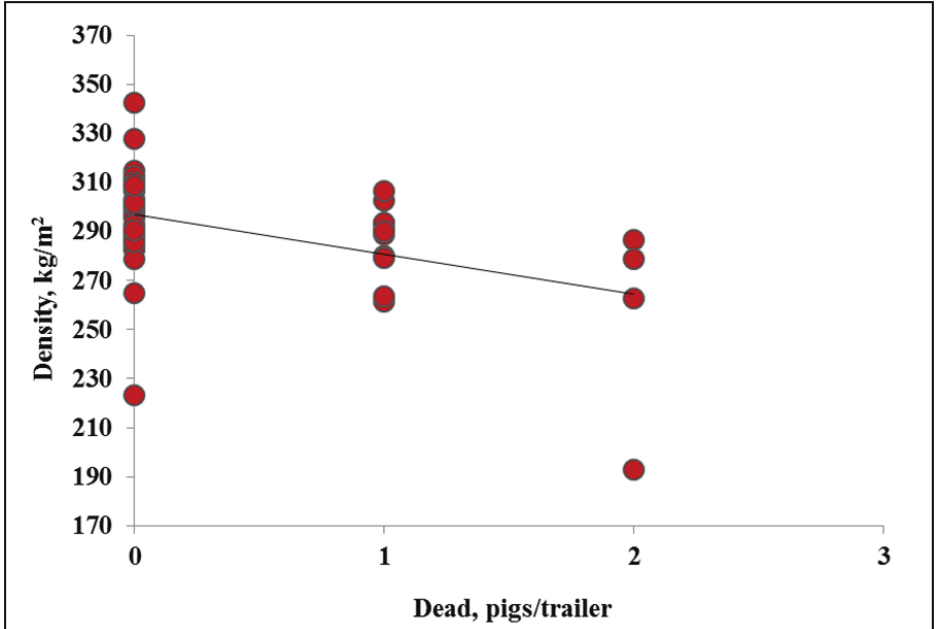
Figure 5. Experiment 2. Effects of density on trailers on dead pigs per trailer in market weight pigs at unloading in HOT weather ((cid:2)26.7 °C; p = 0.01, R 2 =